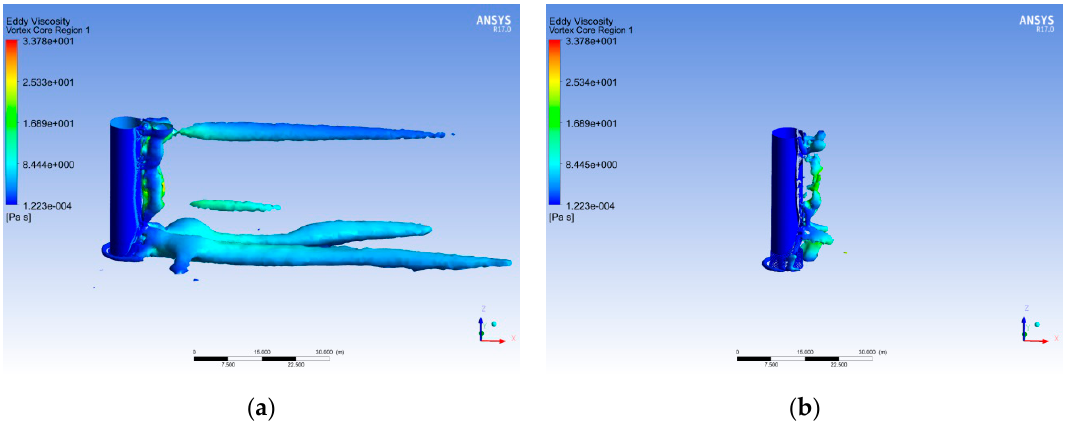
Figure 11. Eddy viscosities: ( a ) before using the fishnet device; ( b ) after using the fishnet device.